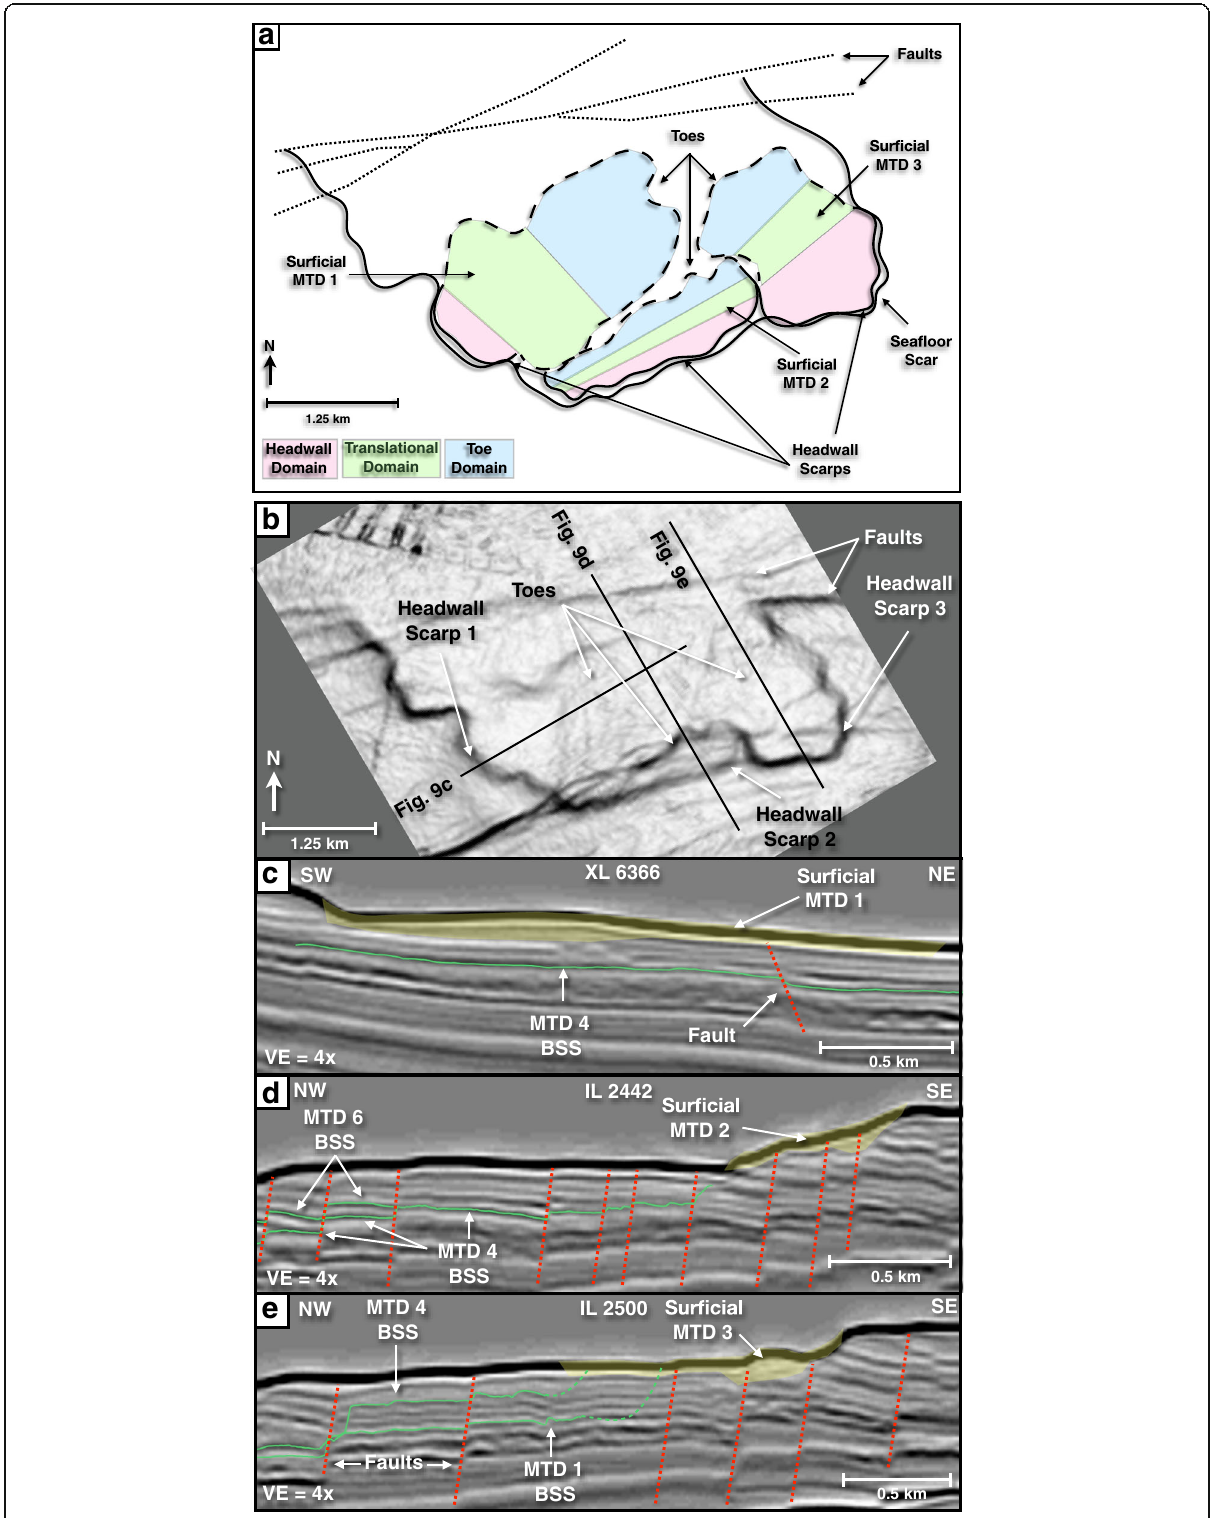
Fig. 9 Surficial MTDs. a Schematic depiction of three surficial MTDs. b Bathymetric image of surficial landslide scar showing the location of three surficial landslides. c – e Seismic cross sections across the surficial MTDs in the 3D seismic data. Green lines are BSSs of older landslides. Red dotted lines are normal